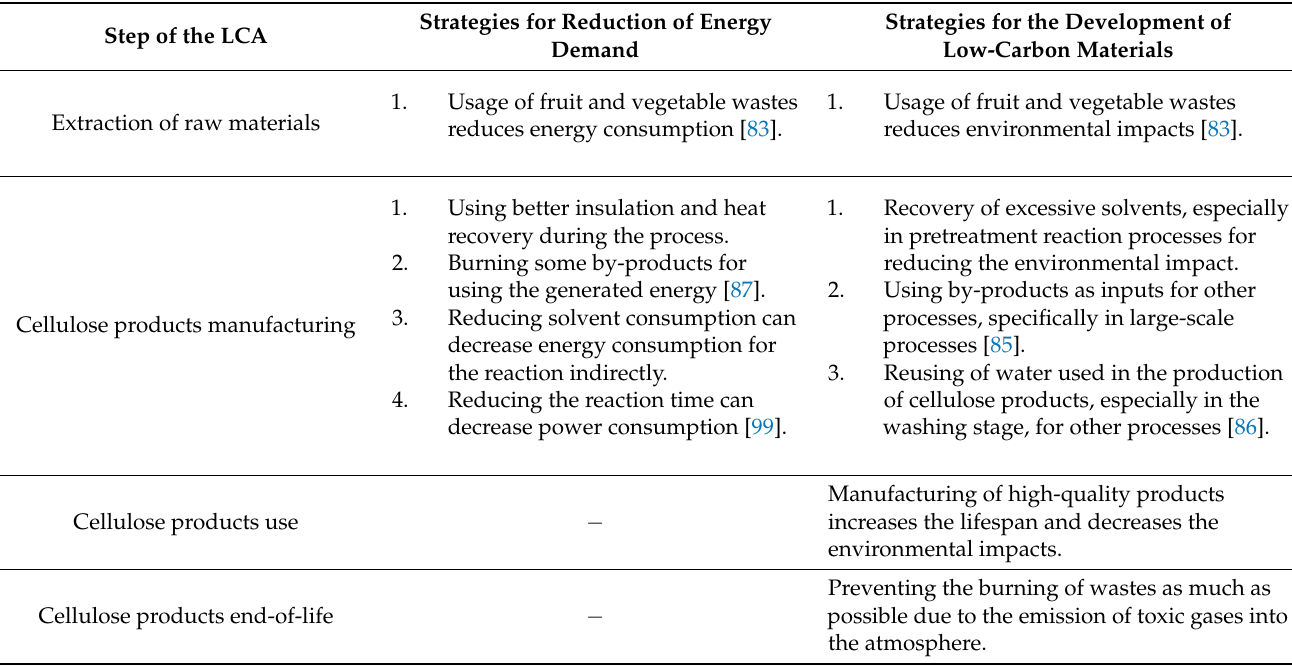
Table 5. Suggested strategies for reducing energy demand and development of a low-carbon economy for cellulose products. Step of the